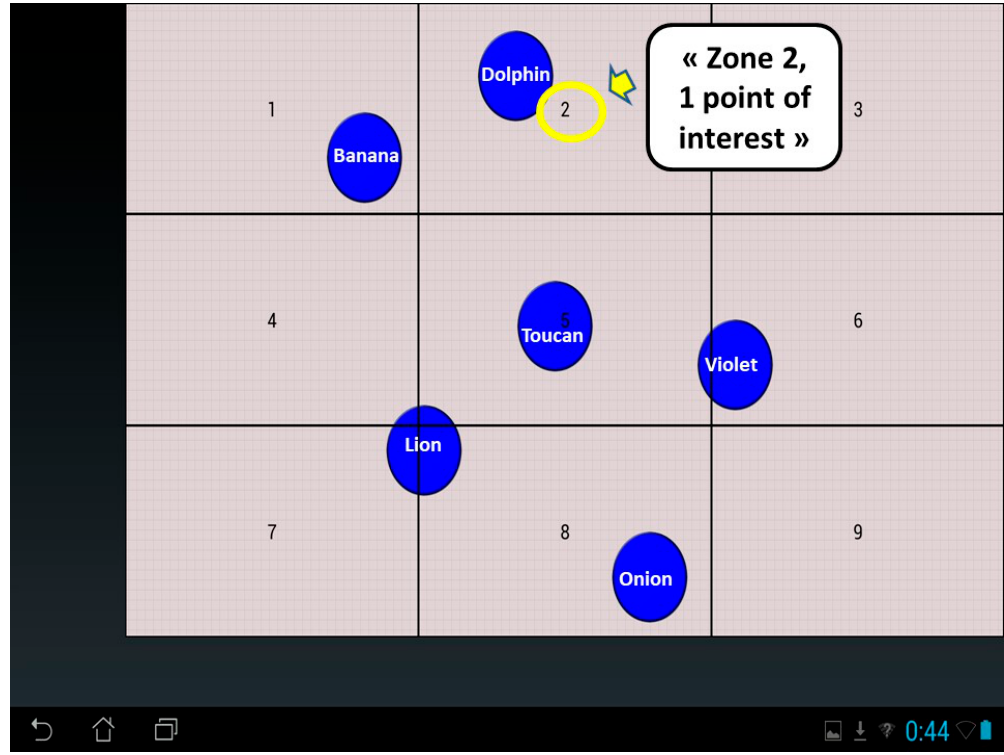
Figure 5. Schematic description of the Grid Layout technique.